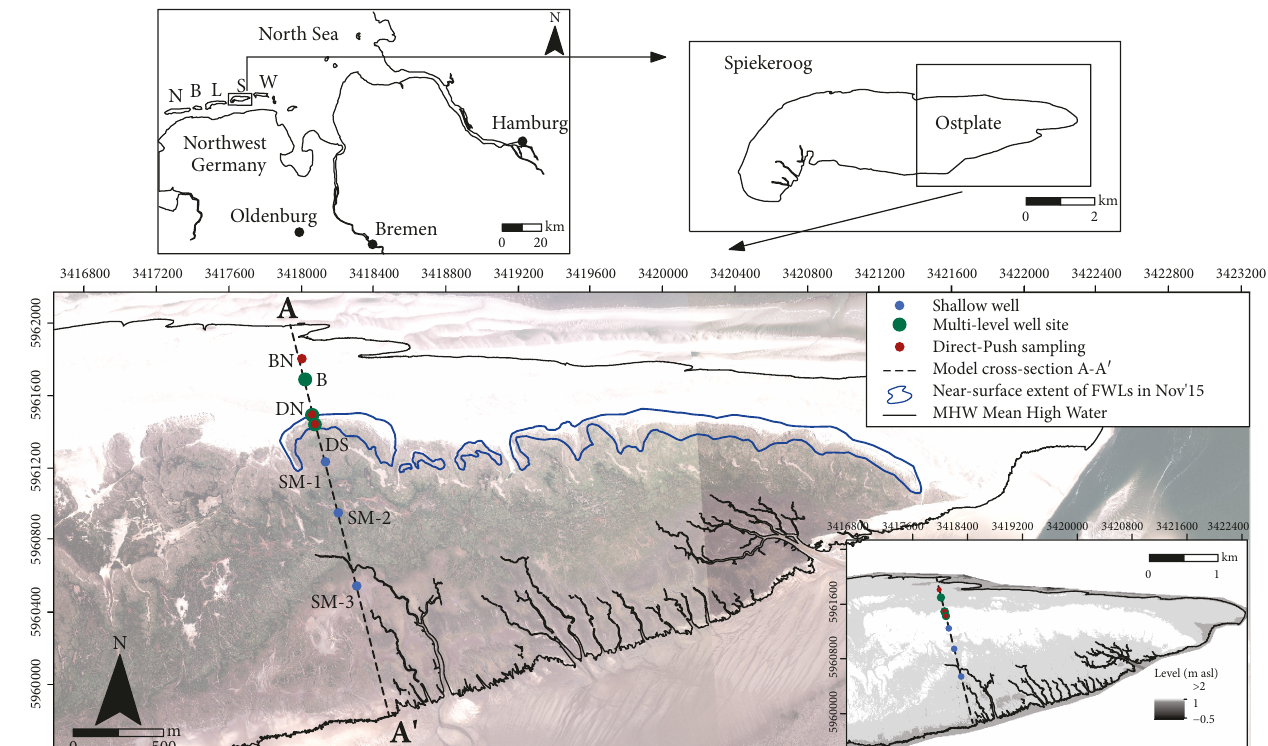
Figure 1: Overview of the Ostplate with the location of the monitoring sites, modelled cross-section A-A ’ , and near-surface extent of FWLs in November 2015, which are restricted to the elevated dune areas [27]. Aerial picture of 2013 as well as the laser-scan elevation model of 2014 was provided by the Lower Saxony Water Management, Coastal Defense and Nature Conservation Agency (NLWKN) [59]. East Frisian Islands (top left): N: Norderney, B: Baltrum, L: Langeoog, S: Spiekeroog, W: